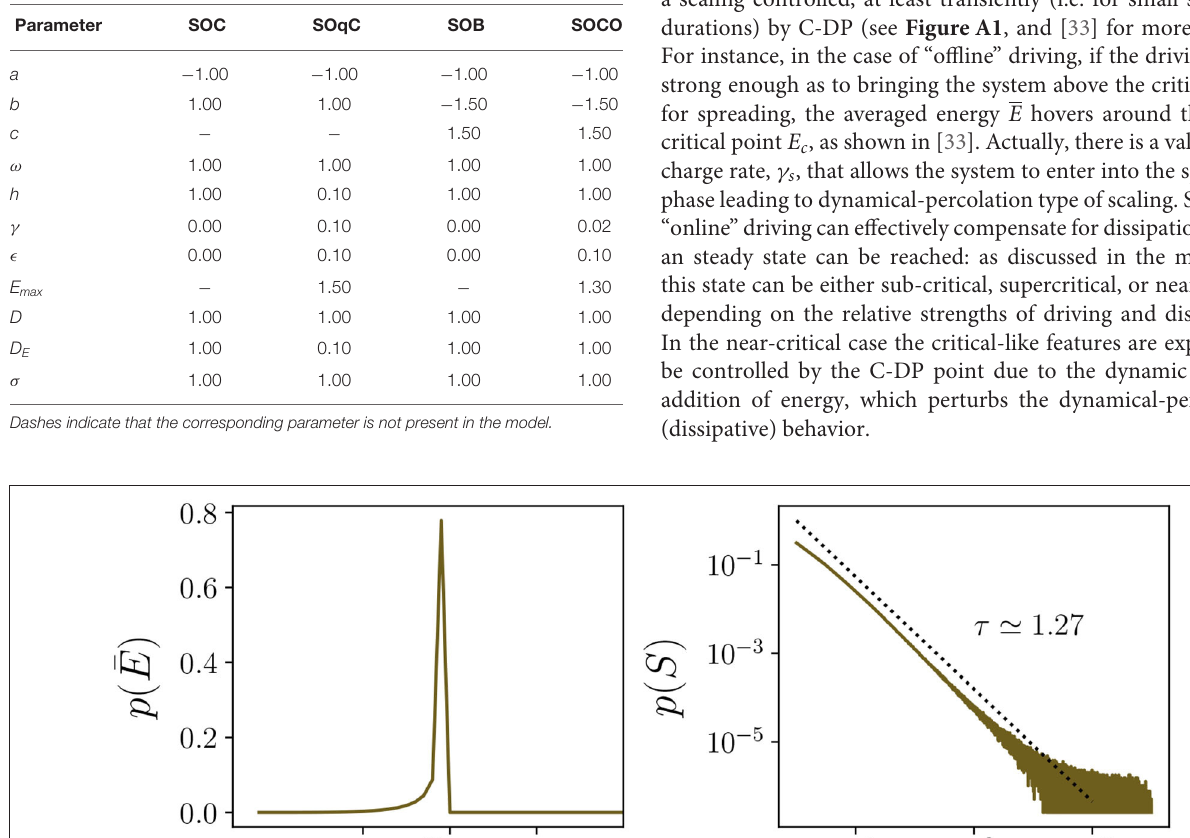
TABLE A1 | Parameters used in the numerical simulations for Figures 1 , 2 . Parameter